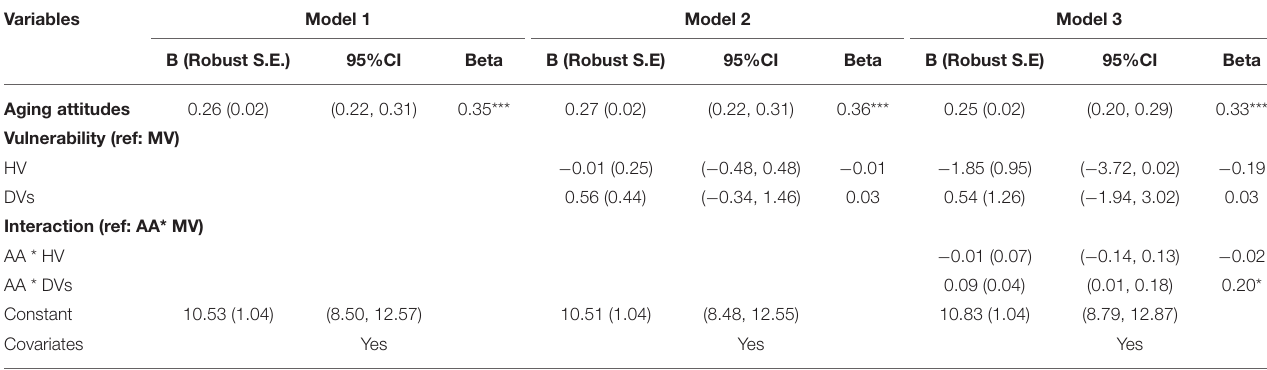
TABLE 4 | Weighted linear regressions of the relationship between aging attitudes, vulnerability type, and positive emotional responses among older adults ( N = 1,539).